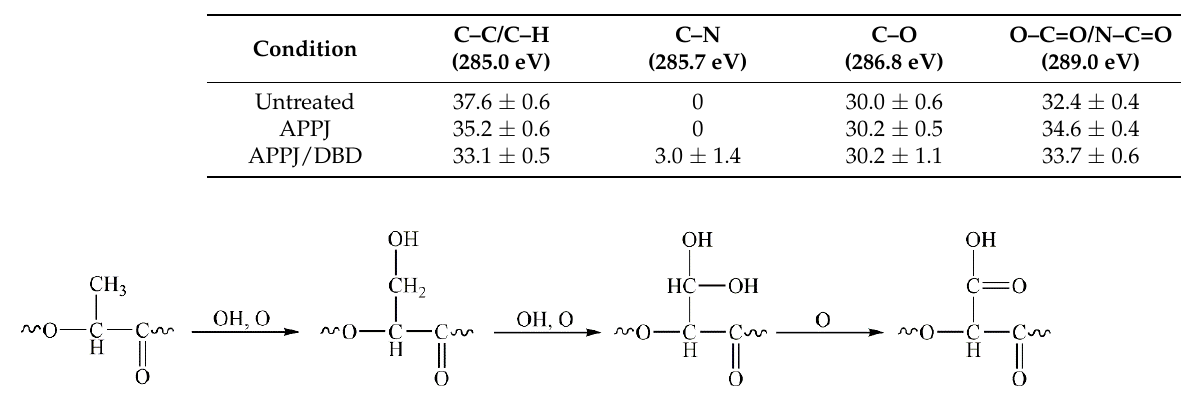
Table 4. Relative concentrations (%) of carbon-containing functional groups on the surface of un- treated, APPJ-treated and APPJ/DBD-treated PLA nanofibers.